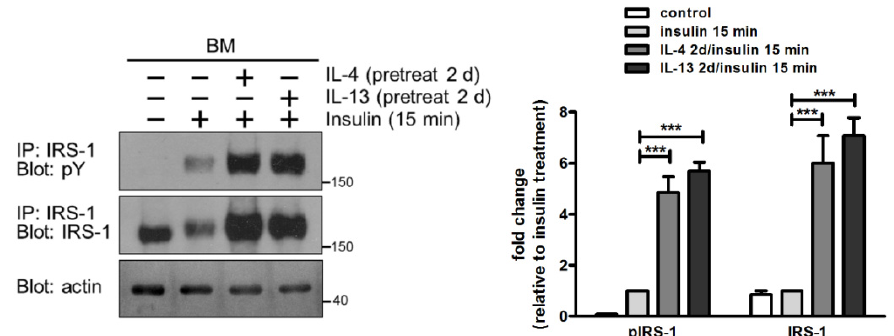
Figure 5. Pretreatment with IL-4 and IL-13 boosts insulin-stimulated tyrosine phosphorylation of IRS-1. Mammary cells were cultured on a basement membrane (BM)-like matrix, Matrigel, in the absence of insulin. Cells were pretreated with IL-4 or IL-13 for 2 d and then stimulated with insulin for 15 min. Total cell lysates were immunoprecipitated (IP) with antibody to IRS-1, followed by immunoblotting with antibody to phosphotyrosine (pY). Blots were stripped and reprobed with antibody to IRS-1. Total cell lysates were analyzed by immunoblotting with antibody to actin. Actin was used as a loading control. Data were quantified, normalized to loading control and expressed as fold change relative to insulin treatment alone ( n = 4). *** p <